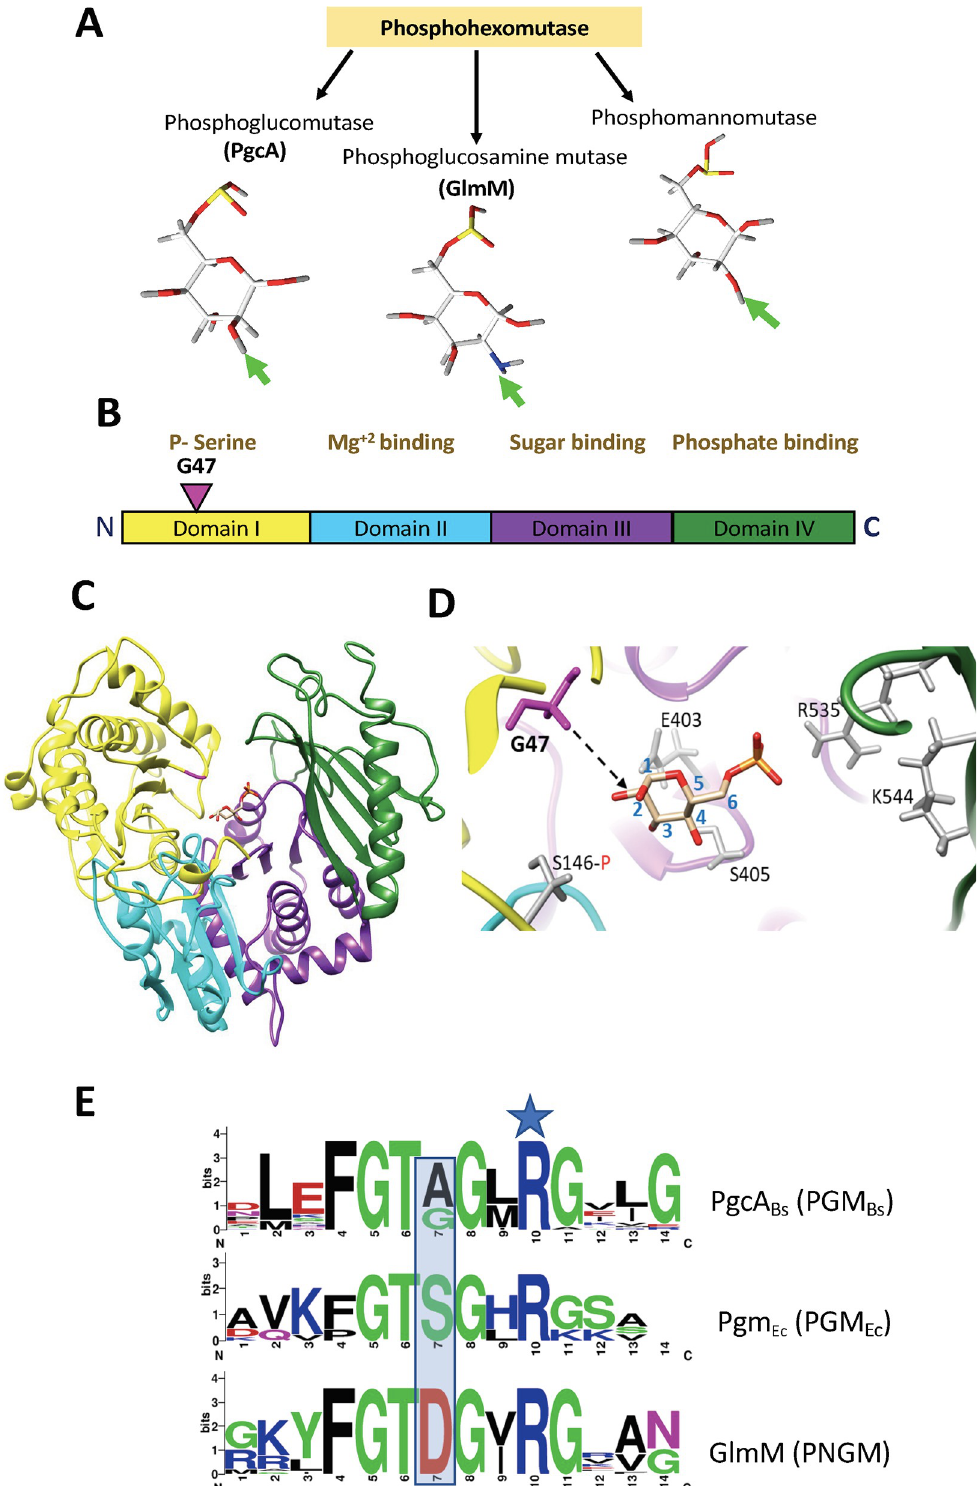
Fig 6. Identification of a mutation affecting substrate-selectivity in PGM/PNGM family enzymes. (A) Schematic depicting enzymes from the phosphohexomutase family and their 6-phosphohexose sugar substrates, with the variable substituents at the C2 position highlighted by an arrow. ( B ) domain structure and conserved functions within PGM